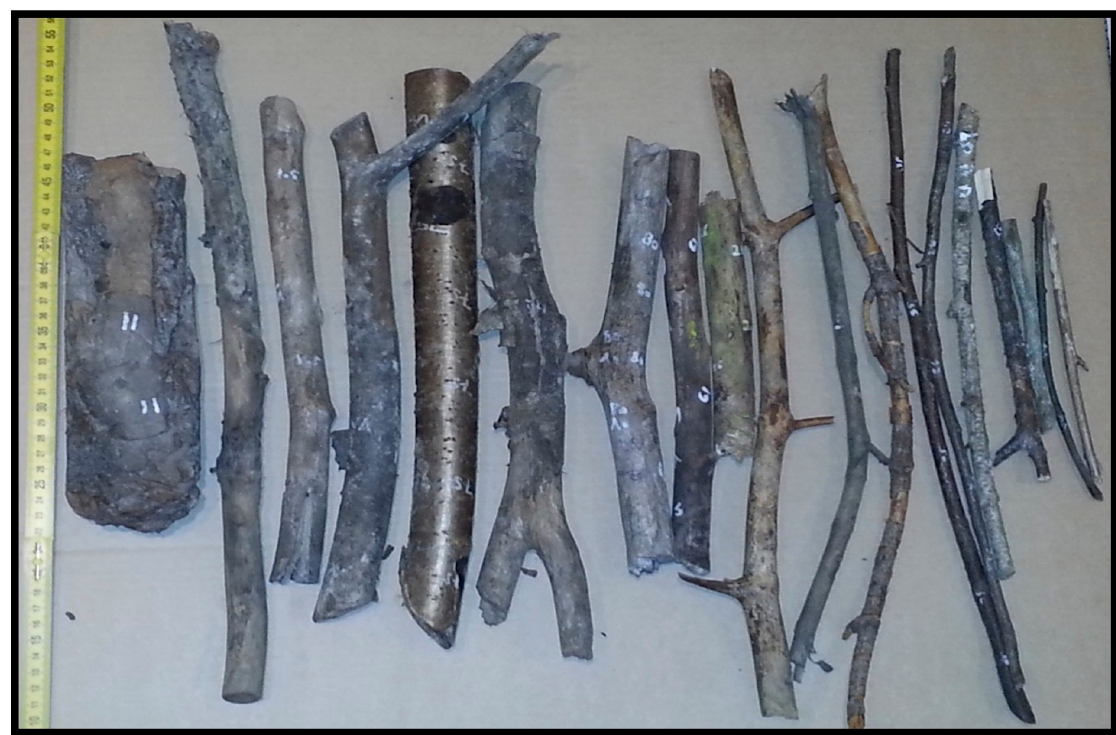
Fig 2. Sample of the tools provided to the chimpanzees (sticks and bark) in Experiment 1.